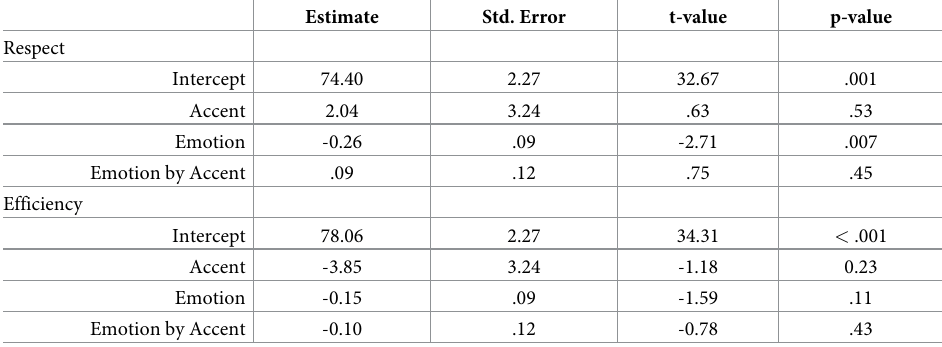
Table 4. Estimates, standard error, t-values, and p-values of the predictor Accent (native, foreign-Indo), Emotion (mean of anger, disgust, sadness, and fear) and their interaction on Respect and Efficiency. Estimate Std.